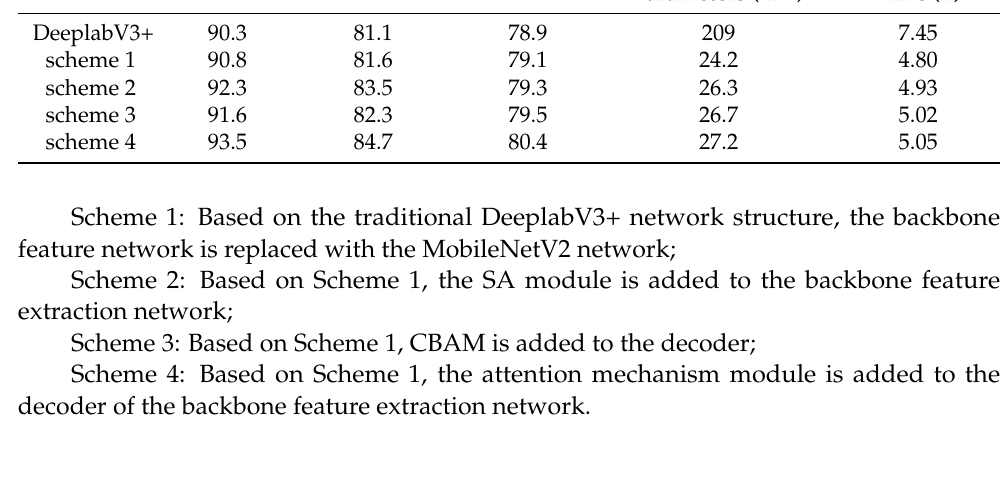
Figure 11. Comparison of segmentation Accuracy of graded disease spots by various Models.